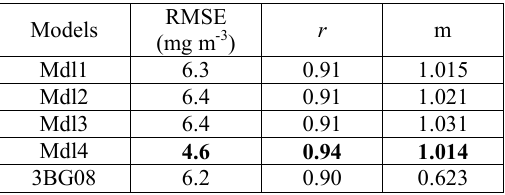
Table 4: Comparison of RMSE, slope ( m ) and correlation coeficient ( r ) and with other studies